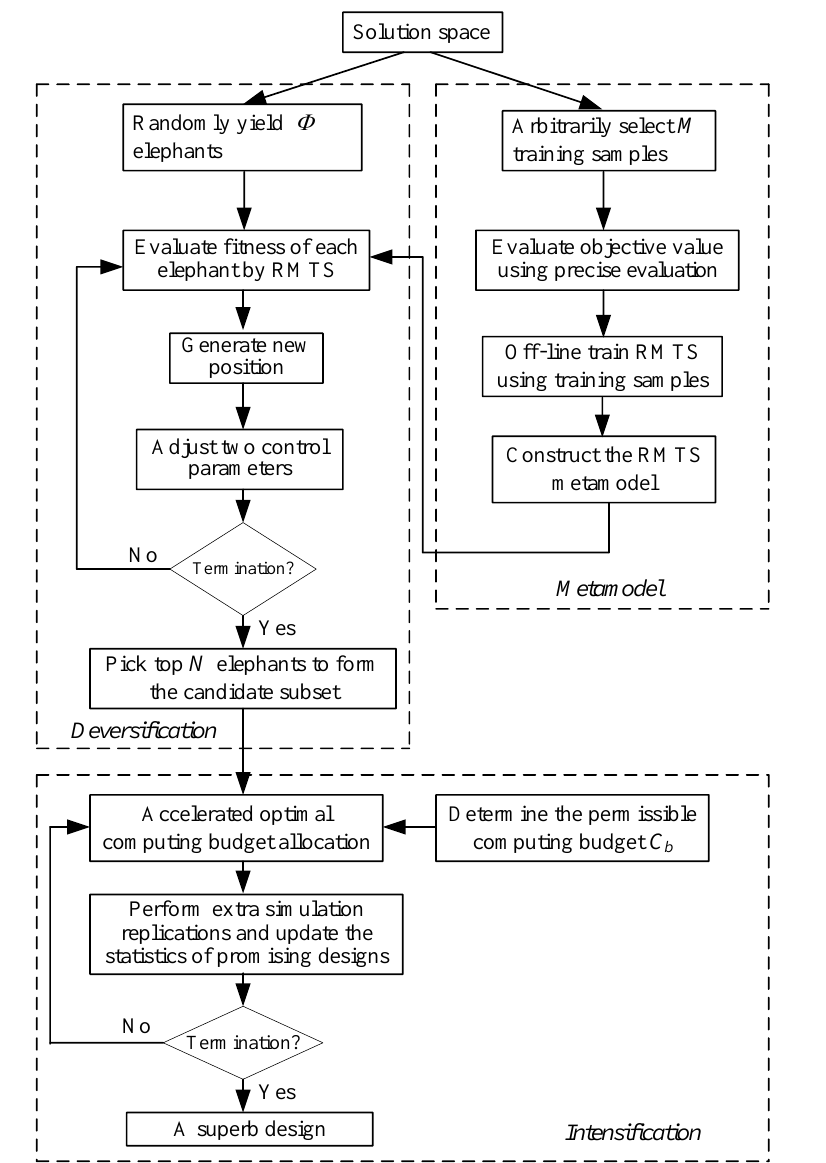
Figure 2. Flow diagram of the coupling elephant herding optimization with ordinal optimization